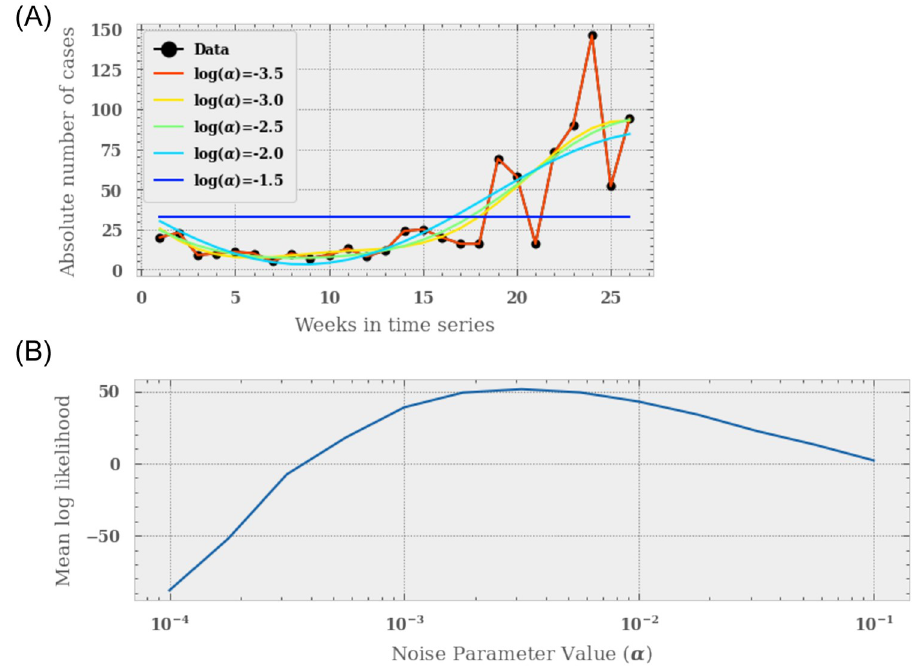
Fig 1. Top : How the fit of the Gaussian Processor Regressor to the time series data depends on the noise value α . Assuming a sine, exponential squared kernel, we see that for small α values the regressor over-fits the malaria (top), fitting every point in each curve. Additionally, at high values of alpha , the regressor tends to the mean of each time series. Bottom : We optimise the noise value through a simple grid-based search for the best fitting value of α . For each time-series we derive a log-likelihood of the model given the data. We then find the alpha parameter that has the best mean log-likelihood over the entire data-set. We find that the log( alpha ) = − 2.75 returns the highest mean likelihood.